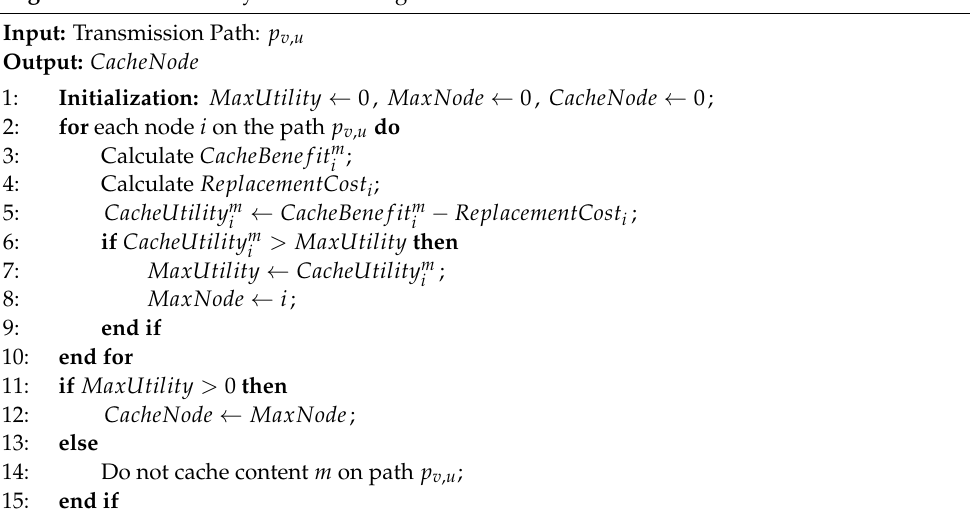
Algorithm 4: Max-Utility-based Caching Node